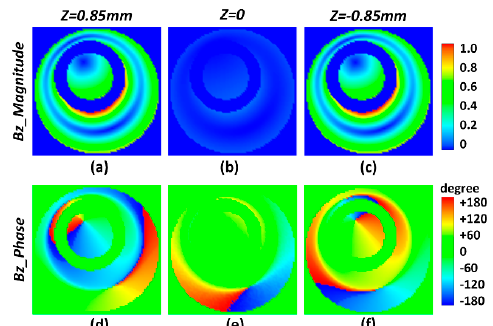
Figure 8. The calculated magnitude and phase of the B z field component from the experiment, ( a ) and ( d ): on the upper plane, which is 0.85 mm away from the central slice, ( b ) and ( e ): on the central slice, ( c ) and ( f ): on the lower plane, which is 0.85 mm away from the central slice.